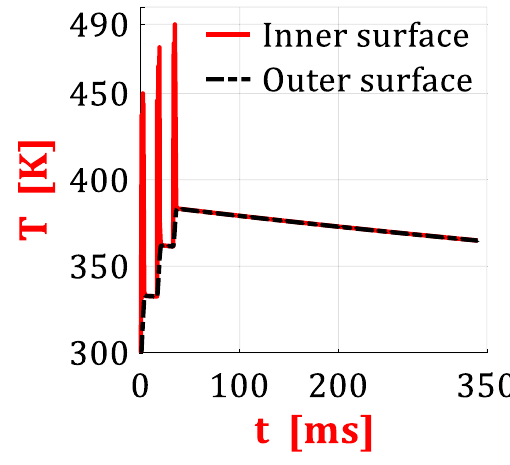
Fig. 19 Inner and outer surface temperatures for applying 85 shocks under the hypothesis of TDMP